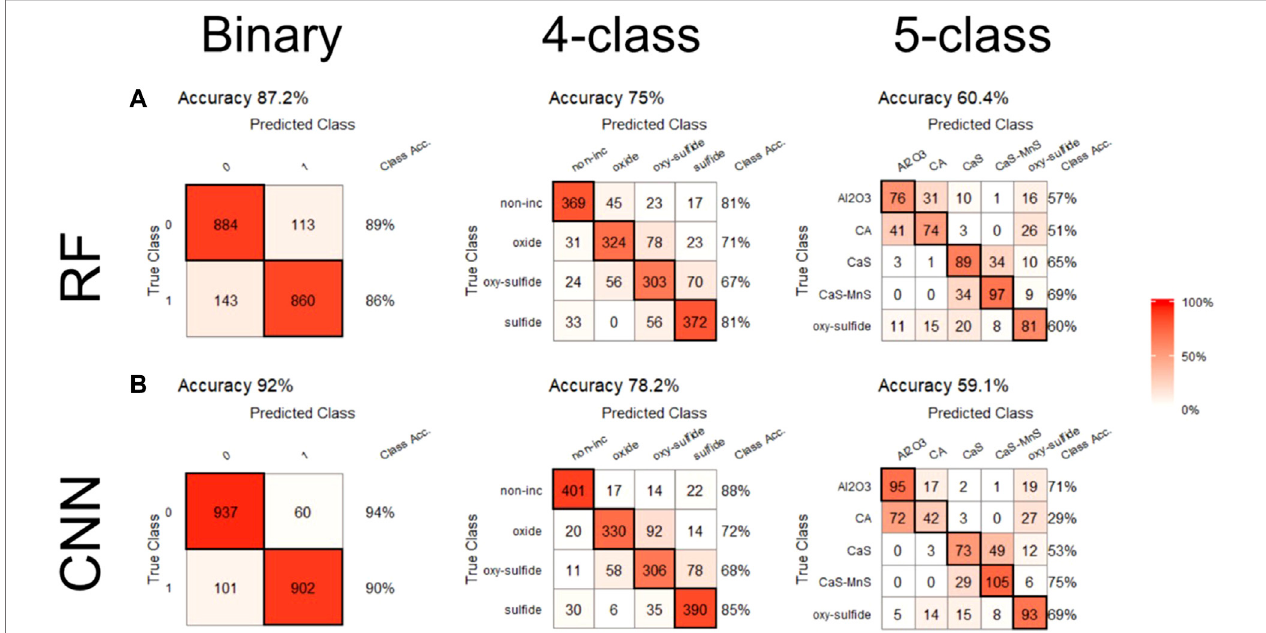
FIGURE 7 | Confusion matrices for prediction results of all three models using RF (A) and CNN (B) .